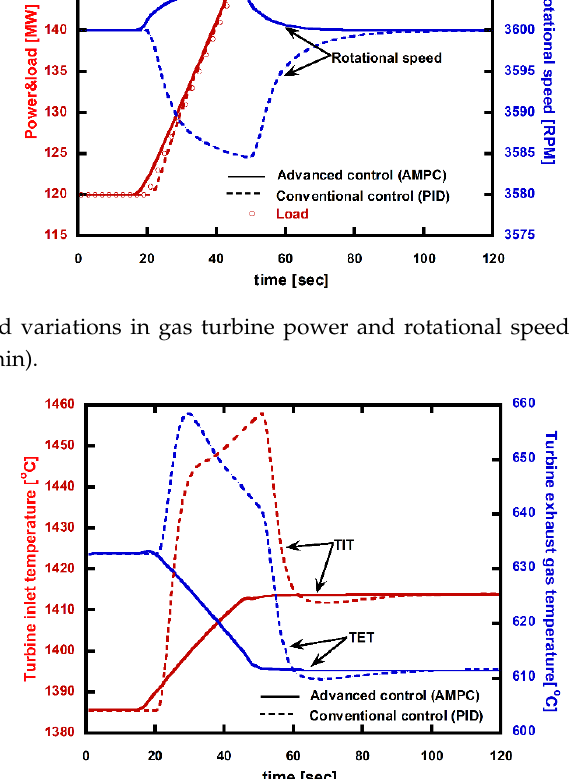
Figure 21. Simulated variations in gas TIT and TET with increasing load (ramp rate: 60 MW/min).